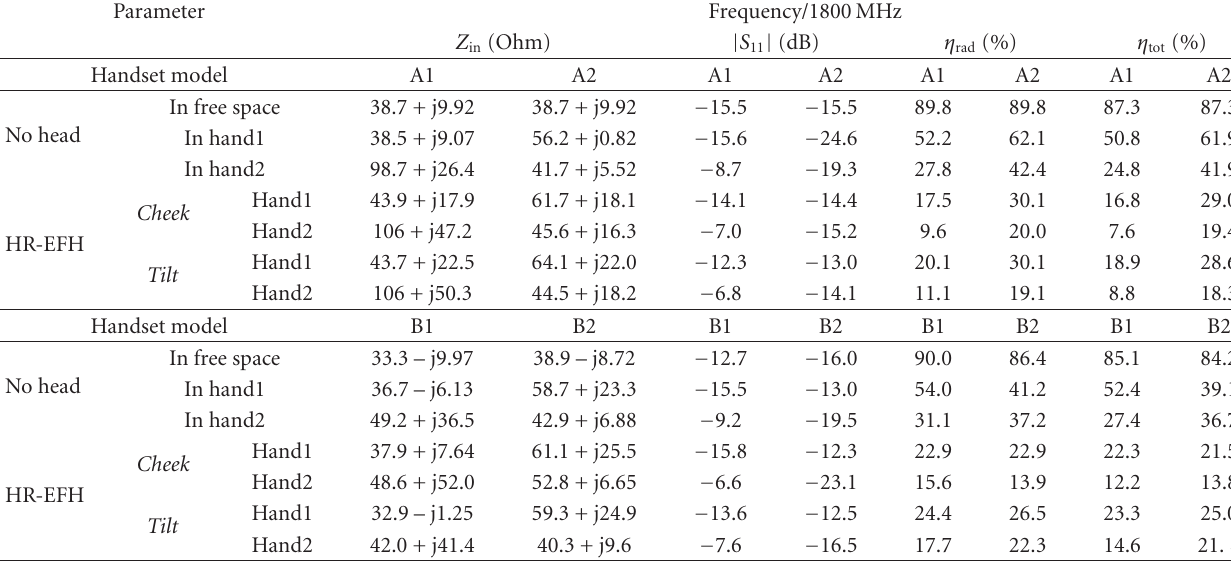
Table 5: Computational results of the antenna input impedance, Z in , | S 11 | in dB, radiation e ffi ciency, η rad , and total e ffi ciency, η tot , for di ff erent handset setups at 1800 MHz.